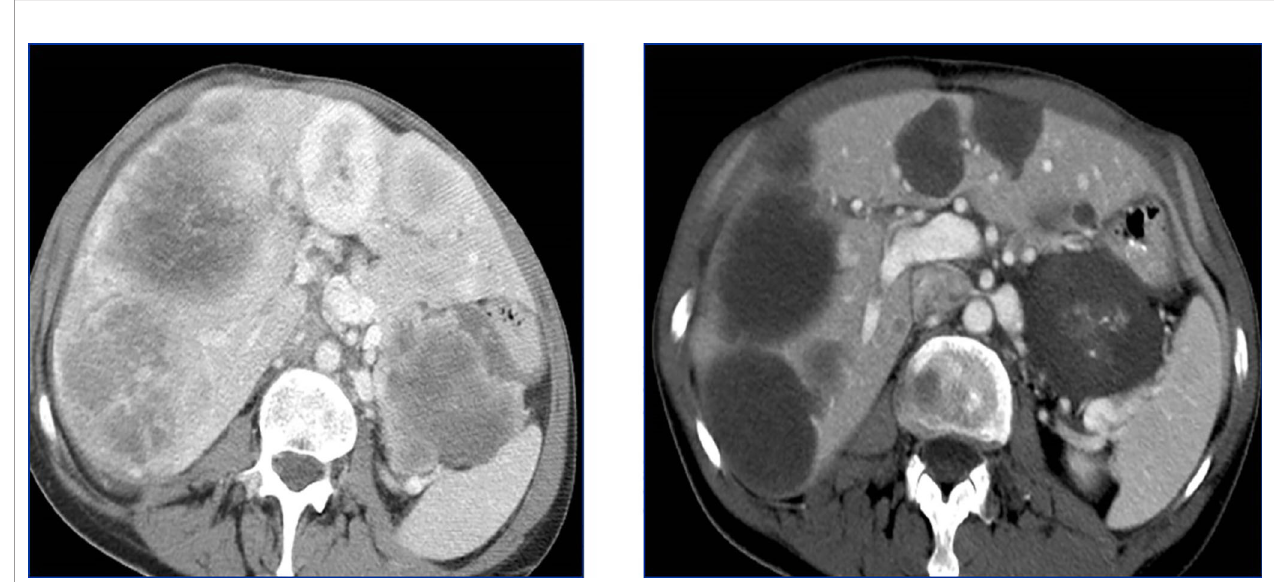
FIGURE 2 | Response unrelated to tumour size in a 66 yo patient treated with imatinib for a gastrointestinal stromal tumour (GIST). Compared to the baseline image (left), after treatment (right) the tumour shows a dramatic decrease in density rather than in